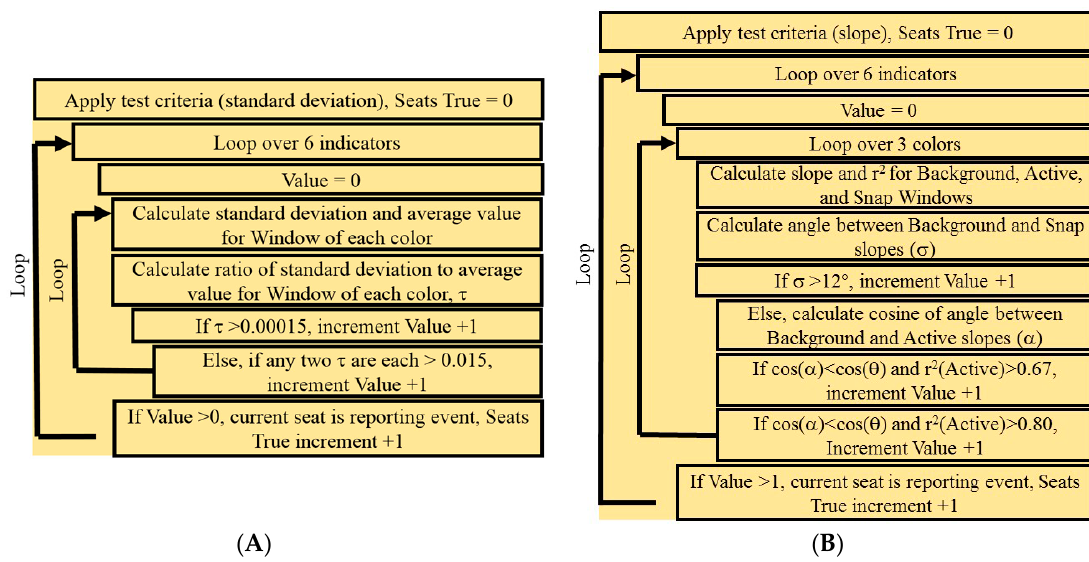
Figure 1. ( A ) Psuedocode describing the test criteria utilized for the standard deviation based algorithm (std); ( B ) Psuedocode describing the test criteria utilized for the slope based algorithm (s1, s2, s3).